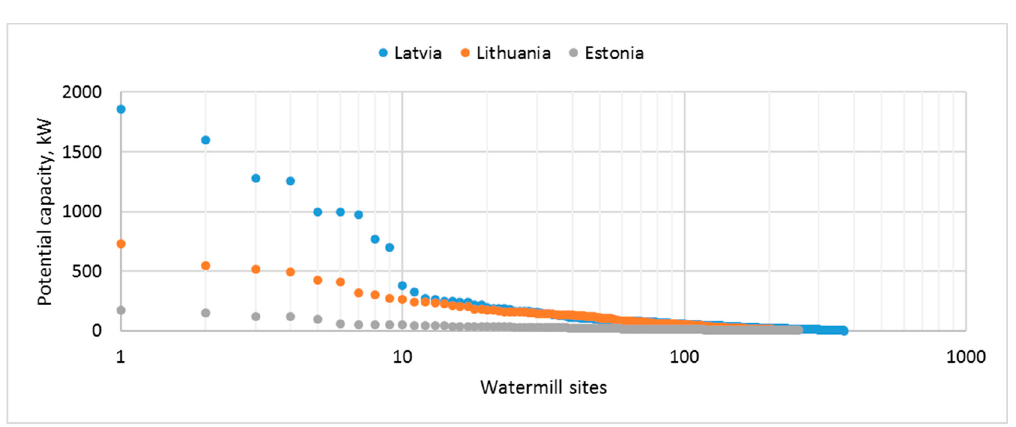
Figure 8. The potential capacity of watermill sites in the Baltic States (note the logarithmic x -axis).